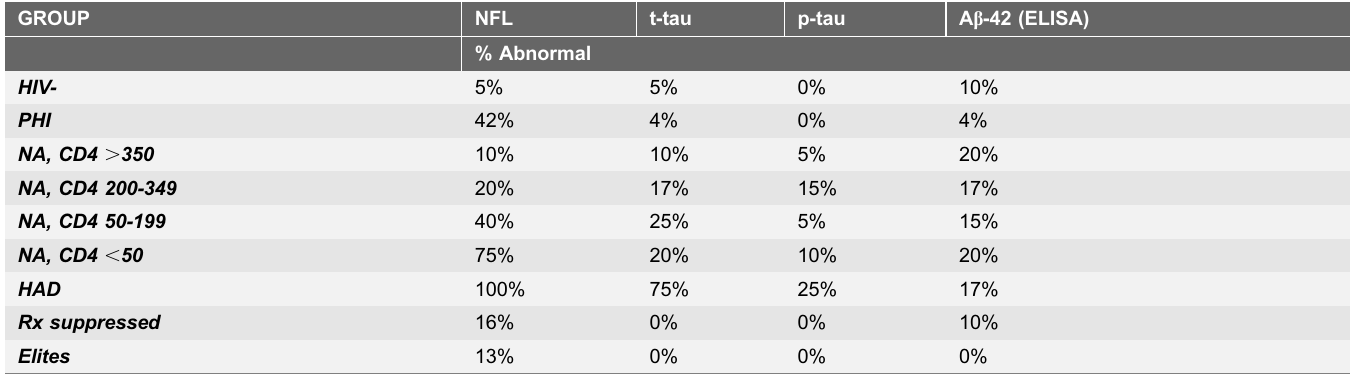
Fig. 1. Concentrations of 6 CSF neuronal biomarkers in the 9 subject groups. Boxes in all panels depict median and IQR, whiskers show 10–90 percentiles and ‘ + ’ designate the means. Dotted horizontal lines show the limits of laboratory norms for the older age groups where available (upper limit of normal for NFL, t-tau and p-tau and lower limit of normal for A b 42). Statistical comparisons of groups are given in Table 3. The biomarker concentrations are displayed in a log 10 ng/L, over a 3 times log 10 range, but at a higher scale range for NFL. Measured markers are listed in the title of each panel and findings described in the text. Some of the CSF NFL results included here have been previously reported in a different context [4,10,49], including within a larger data set characterizing CSF in relation to age [48]; here, the number of subject groups is expanded and we emphasize the comparison of NFL with the other neuronal biomarkers which have not been previously reported. doi:10.1371/journal.pone.0116081.g001 Table 2. Prevalence of age-related abnormal CSF biomarkers in